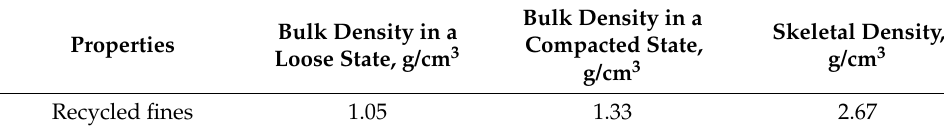
Table 3. The main properties of recycled fines (RF).